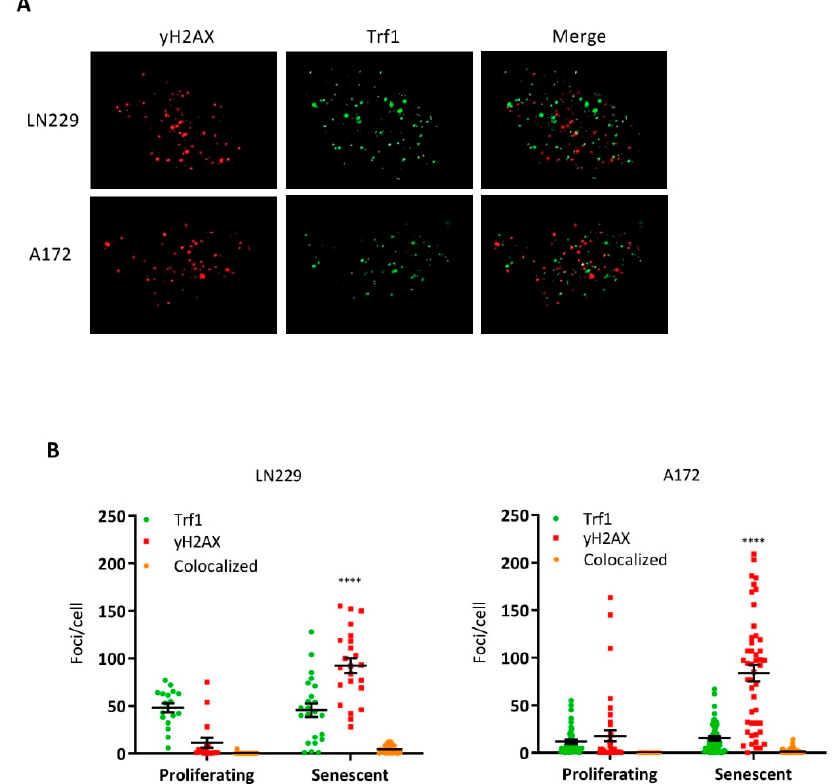
Figure 3. DNA double-strand breaks and telomeres labeled through Trf1 in TMZ-treated LN229 and A172 cells. ( A ) Representative images of γ H2AX and Trf1 staining in senescent LN229 and A172 cells (8 days after TMZ treatment). ( B ) Quantification of Trf1 and γ H2AX foci and their colocalization in proliferating and senescent LN229 and A172 cells. At least 50 cells were analyzed in each case. The difference in γ H2AX foci between proliferating and senescent populations was highly significant, **** p <0.0001.